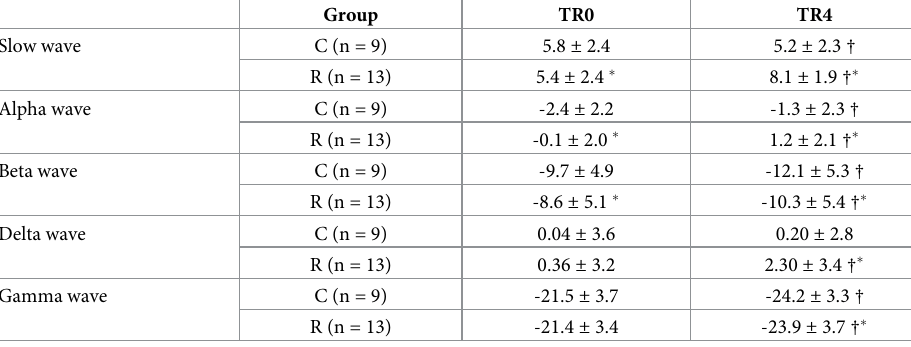
BIS, PLE, EMG_PLE, PLE1, or PLE2 were observed at any time point compared to TRV0 (immediately before administration of the study drugs) in either group, only EMG_BIS increased significantly at TRV4 compared to TRV0 in group B (Table 8). Mean blood pressure and heart rate did not change significantly compared to TRV0, and no significant differences were observed between the two groups (P > 0.05) (S3 Table). The changes of BIS and PLE after complete recovery from NMB under general anesthe- sia. At 4 min after administering sugammadex, all patients had a TOF ratio � 100%. There- fore, we performed statistical analyses to evaluate the effects of complete recovery from NMB on the BIS and PLE during general anesthesia by comparing the values at TRV4 and TRV0. In groups D and B, no significant changes were observed in the BIS or PLE at TRV4 compared to TRV0, despite significant increases in EMG_BIS and EMG_PLE in group B (Table 9). There was no unintended awareness or perioperative side effects related with study protocol in all patients.